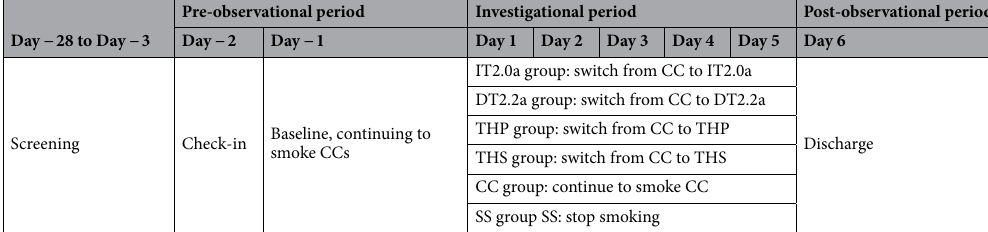
Table 1. Study design schematic. CC combustible cigarettes, DT2.2a direct tobacco heating system platform 2 generation 2 version a, IT2.0 indirect tobacco heating system platform 2, SS stop smoking, THP tobacco heating product, THS tobacco heating